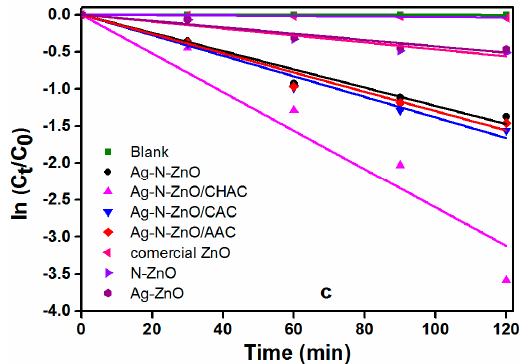
Figure 7. Photocatalytic degradation efficiency ( a ) (30 mg/L initial concentration of MO solution), photocatalytic degradation efficiency of dark adsorption eliminated ( b ) (initial concentration of MO solution after dark adsorption experiment), and kinetic curves ( c ) of photocatalytic degradation of MO over different photocatalysts under visible light irradiation.